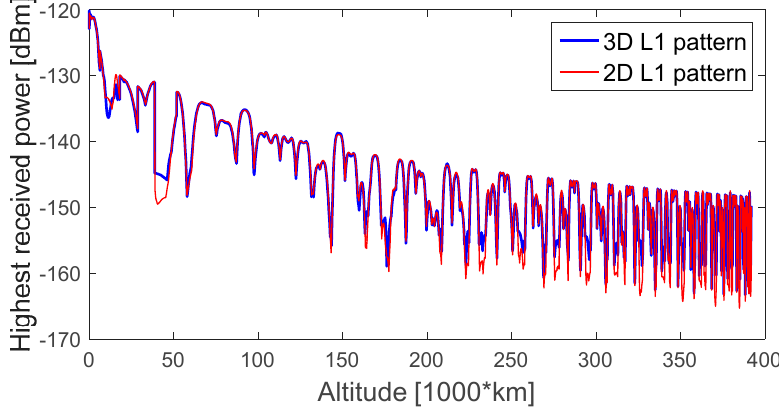
Figure 6. Highest received power level of GPS L1 signals, during the considered MTO, for a 0 dBi receiver gain pattern.